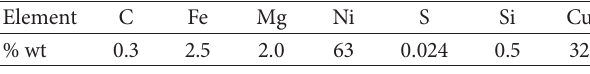
Table 1: Composition of Monel 400.